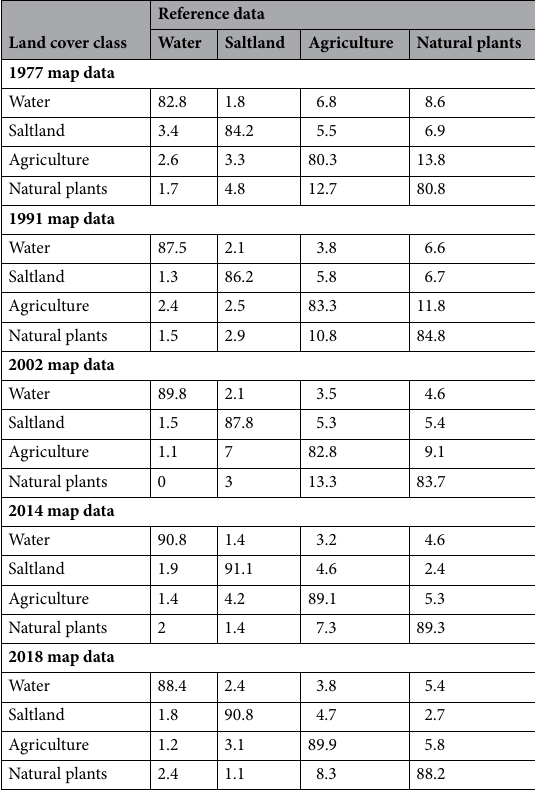
Table 2. The confusion matrix of Land-use/ land-cover of upstream (a) 1977, (b) 1991, (c) 2002, (d) 2014, (e) 2018.